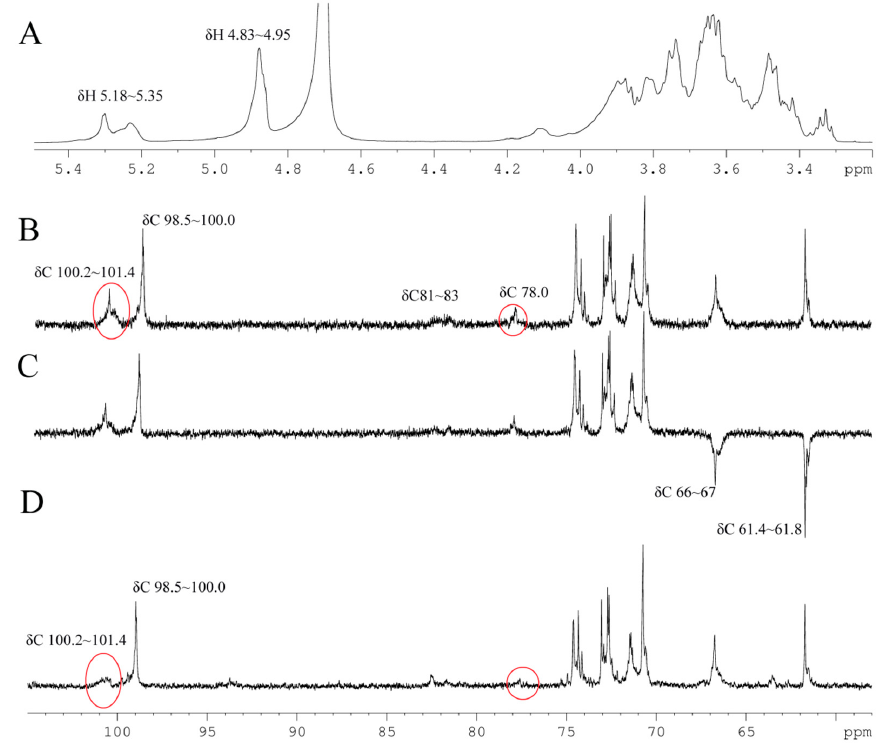
Figure 2. 1D-NMR spectra of BP1. ( A ) 1 H-NMR; ( B ) 13 C-NMR; ( C ) DEPT135-NMR and ( D ) 13 C-NMR of BP1a. The signals highlighted in red indicate the changes of C1, C3 of 3 α - D -Glcp 1 and C4 of 4 α - D -Glcp 1 caused by partial acid hydrolysis.